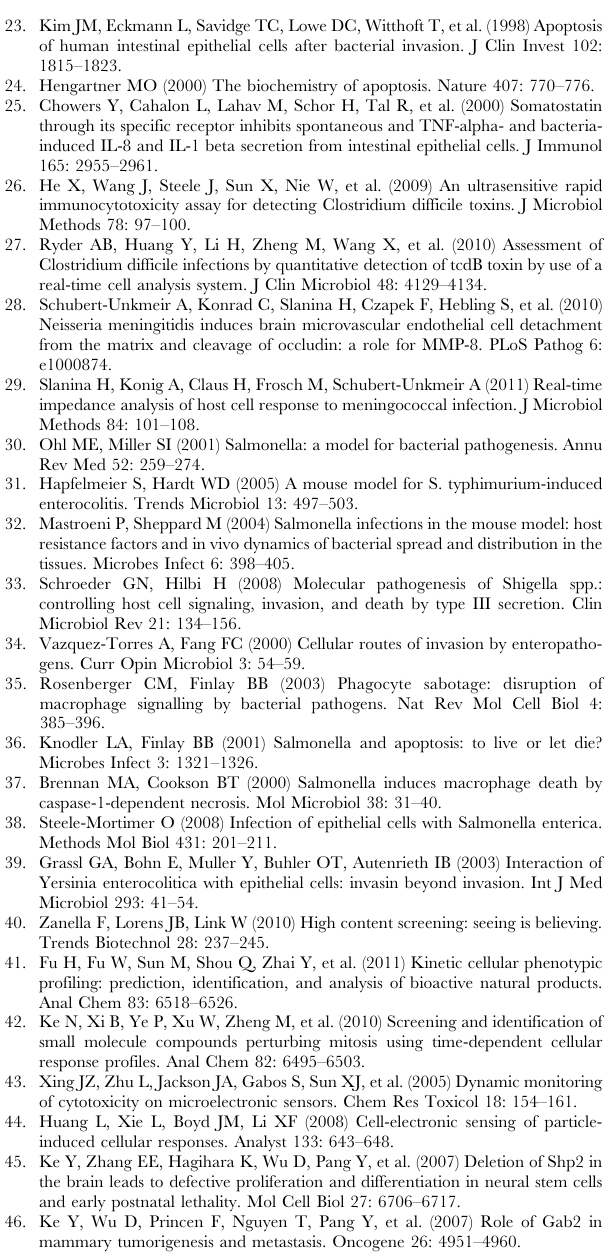
Table S4 MICs of eight antibiotics for Salmonella strain